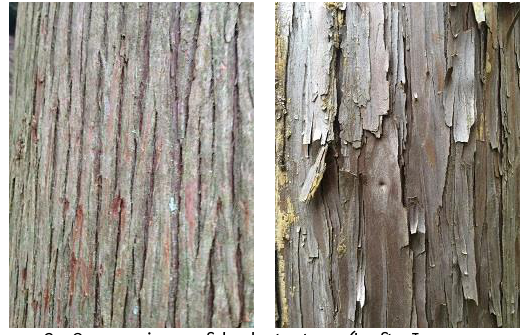
Figure 2. Comparison of bark texture (Left: Japanese cedar, Right: Japanese